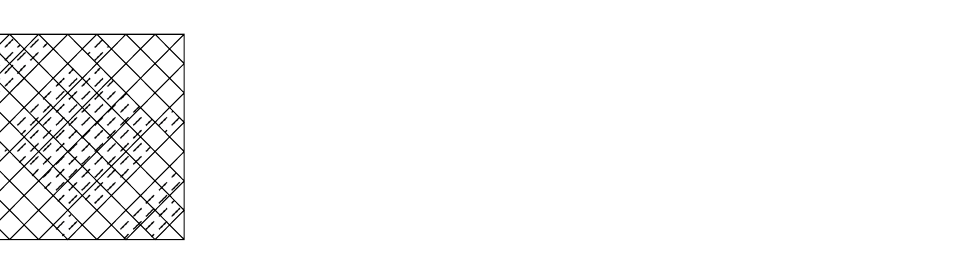
Figure 16. Structure of the second optimized metasurface 111000111001101000111.